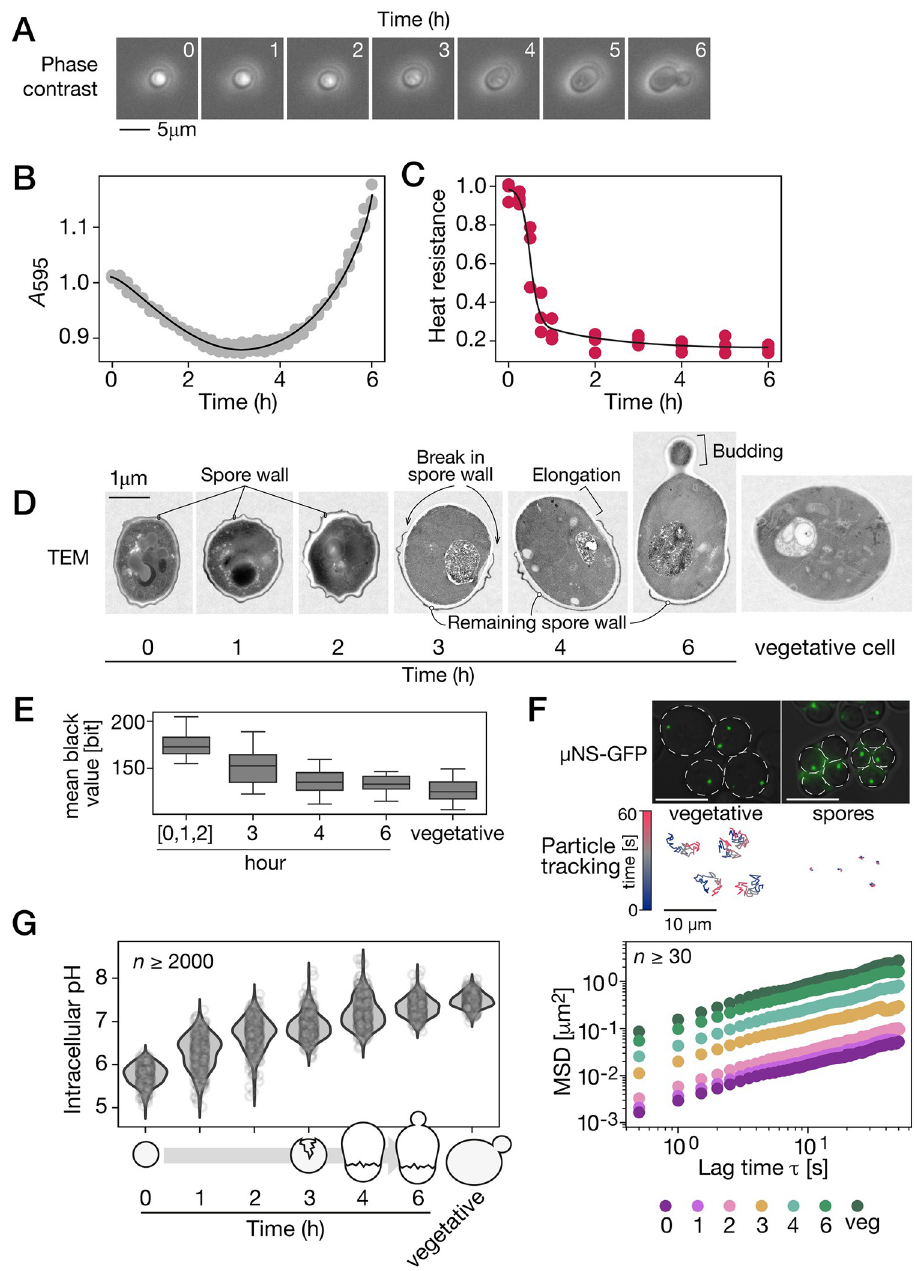
Fig 1. The cytoplasm of dormant spores displays high rigidity and density and is an acidic environment. (A) Phase-contrast microscopic images of ascospore (same cell followed through time) at the indicated time after exposure to rich media, which activates germination. The scale bar represents 5 μ m. (B) Optical density (A 595 ) and (C) heat resistance of pure spore cultures through time after exposure to rich media. Heat resistance is the ratio of growth after a heat shock at 55˚C for 10 min to growth without heat treatment. Experiments were performed in triplicate and values for individual replicates are shown. (D) Representative TEM images of spores at the indicated time after exposure to rich medium and of a vegetatively growing yeast cell (vegetative). Cells were prepared and stained at the same time. Imaging was performed on a single layer. The scale bar represents 1 μ m. See S1A Fig for more examples. (E) Mean black level of spore cytosol at the indicated time after exposure to rich medium and of vegetative yeast. Spores at 0, 1-, and 2-h time points are merged into a single category since they are indistinguishable from one another. (F) Top, microscopic images of μ NS-GFP particles in vegetative yeasts and spores. Underneath is the corresponding 1-min trajectories of the particles. Color indicates time scale. The scale bar represents 10 μ m. Bottom, ensemble MSD of μ NS-GFP particles in spores at the indicated time after exposure to rich medium and in vegetative cells. (G)